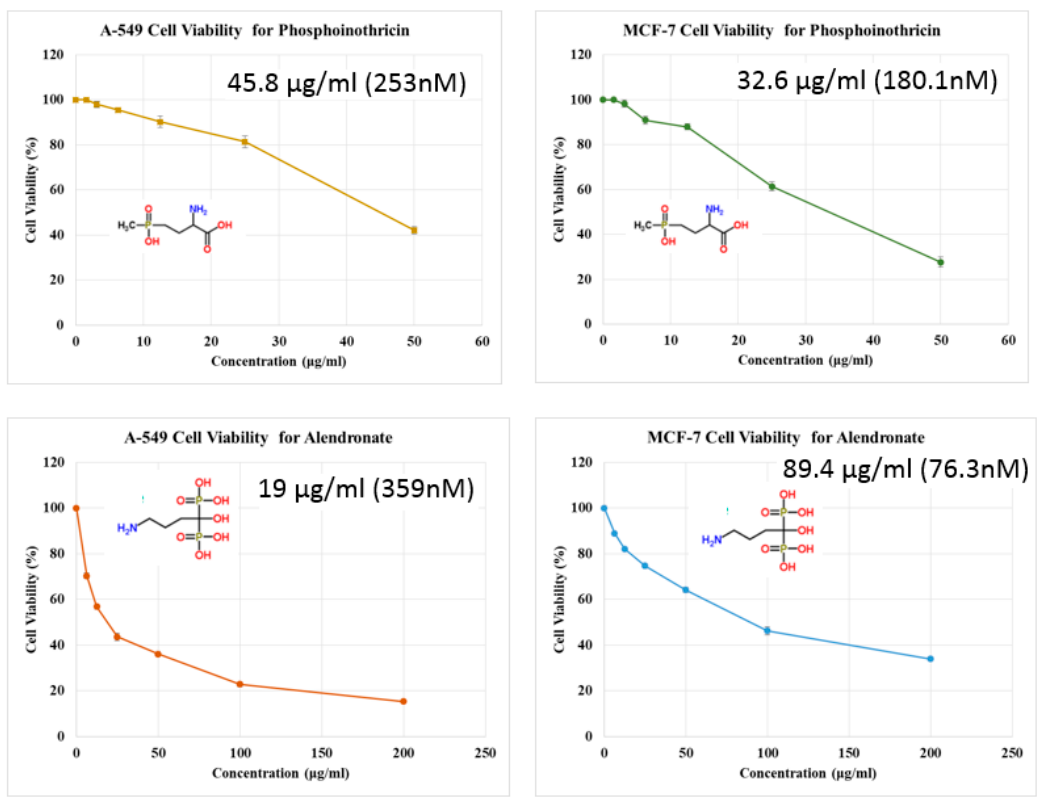
Figure 13. In vitro anti-cancer evaluation of phosphinothricin against breast cancer MCF-7 cell line (B&D) and lung cancer A-549 cell line (A&C).